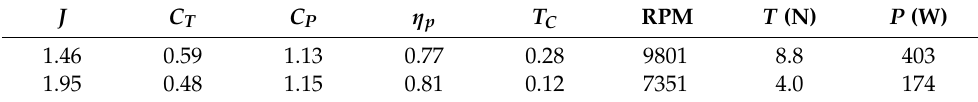
Table 5. Scaled engine deck for power-on wind tunnel tests—average climb conditions at 5000ft.